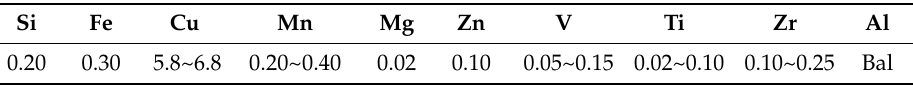
Table 1. The chemical compositions of 2219 Al alloy used in this test